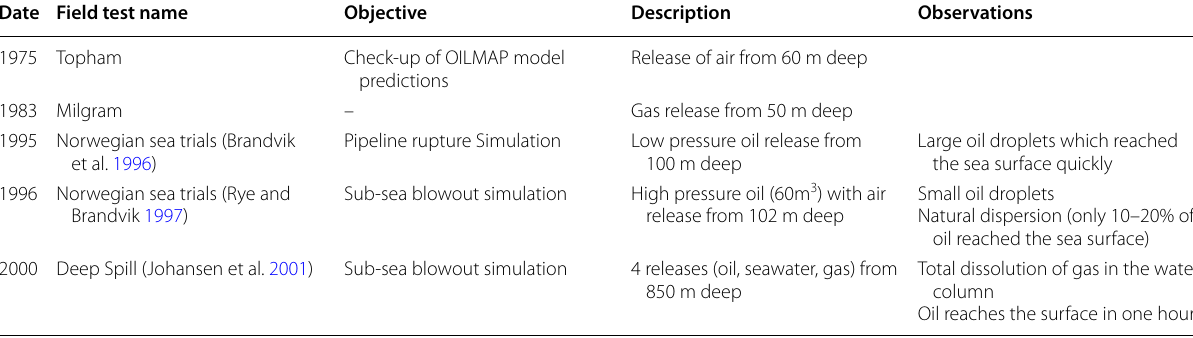
Table 2 Main field trials completed on oil or gas sub-sea releases ( Guyomarch 2002